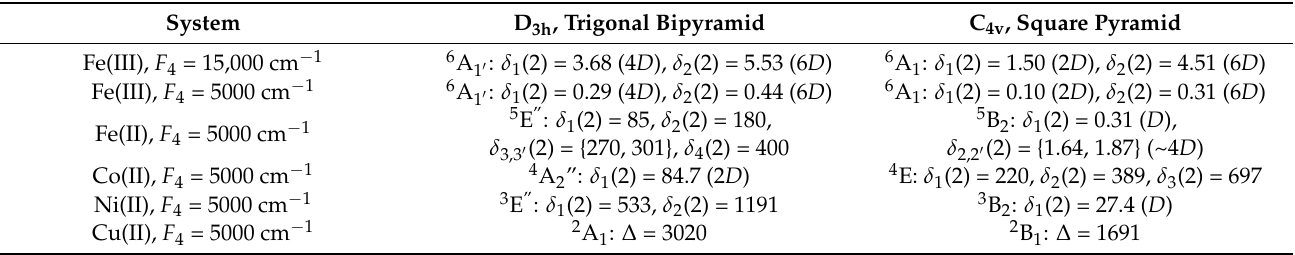
Table 1. Multiplet gaps (in cm − 1) calculated by GCFT for pentacoordinate systems. System D 3h , Trigonal Bipyramid C 4v , Square